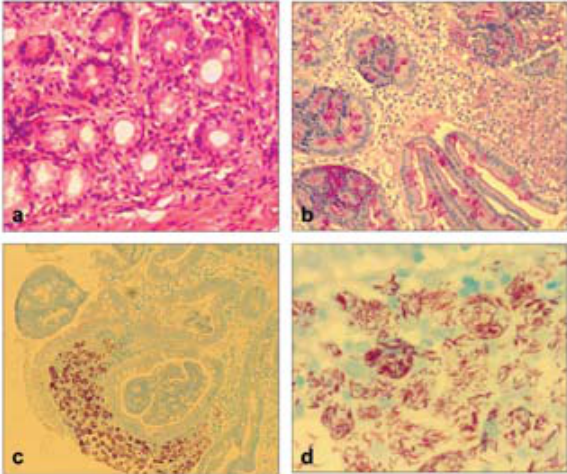
Fig. 1. Sections from white plaques biopsied in duodenum: a – H&E stain; b – PAS stain showing numerous clumps of organisms in histiocytes; c – ZN stain showing clumps of acid-fast bacilli; d – closer view of collection of acid-fast bacilli in ZN